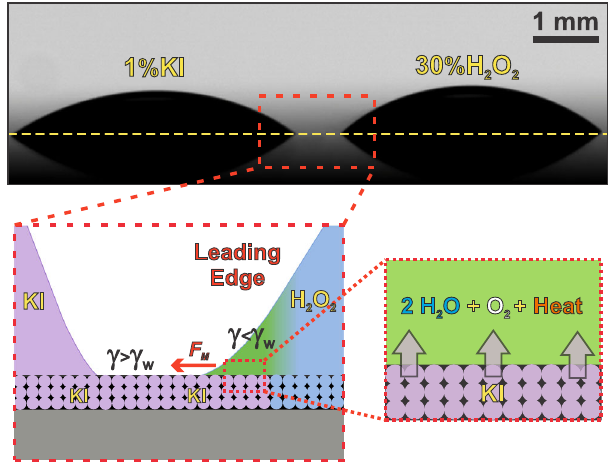
Fig. 4 Schematic representation of the underlying nanopore gating for macroscopic liquid movement. The picture shows a side-view of the interacting KI and H 2 O 2 droplets after placed on the nanoporous surface. The zoom schematics illustrate the locally active droplet resulting from the nanopore-mediated underlying communication with the neighboring droplet. The catalyzed decomposition of hydrogen peroxide takes place in the region where a fraction of the H 2 O 2 droplet perimeter overlaps the annulus of the KI droplet. The droplet can locally escape from the steady- state shape if the energy associated with chemical reaction overcomes the pinning energy barrier. The temperature increases in the reaction zone, O 2 concentration follows the same trend and in turn the H 2 O 2 concentration decreases. This chemical and thermal scenario leads to localized variations of the surface tension, which induce the Marangoni stress F M (tangential force per unit area) that drag the liquid from the H 2 O 2 droplet towards the KI droplet (red arrow), in the direction parallel to the substrate, over the KI